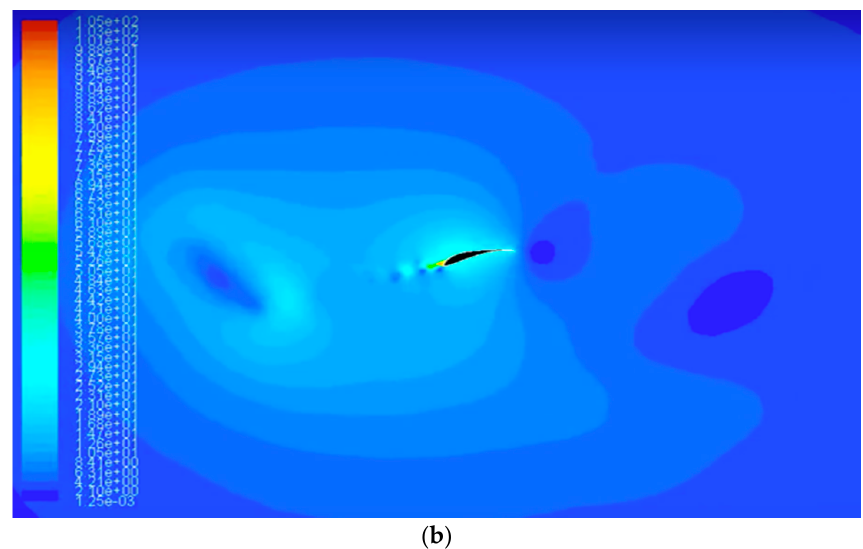
Figure 9. Dynamic computational simulation illustration of a reciprocating cycle: ( a ) Forward stroke with a positive AoA, and ( b ) backward stroke with a positive AoA.